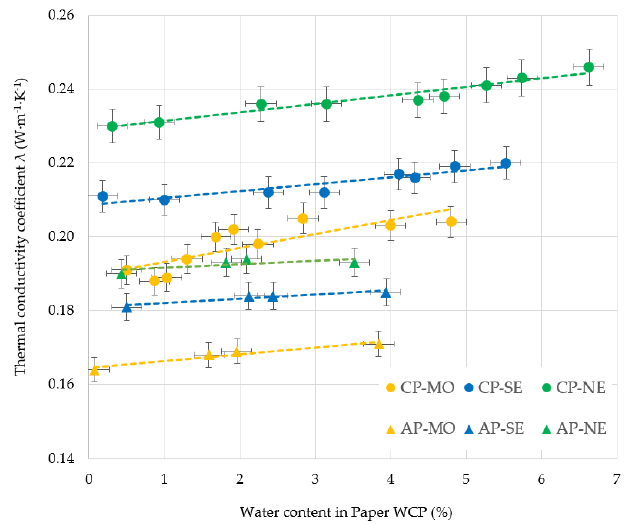
Figure 4. Thermal conductivity of paper insulation depending on moisture WCP measured at 80 °C, for various types of paper and insulating liquid.